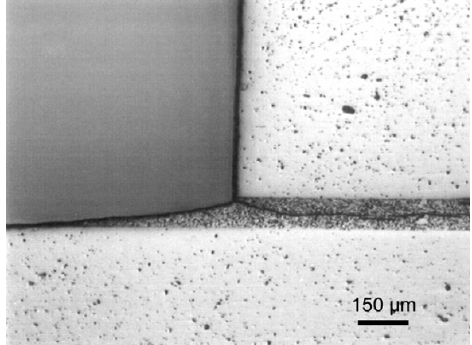
Figure 1: Crack bifurcation in AMZ layer. With courtesy of R. Bermejo [23].